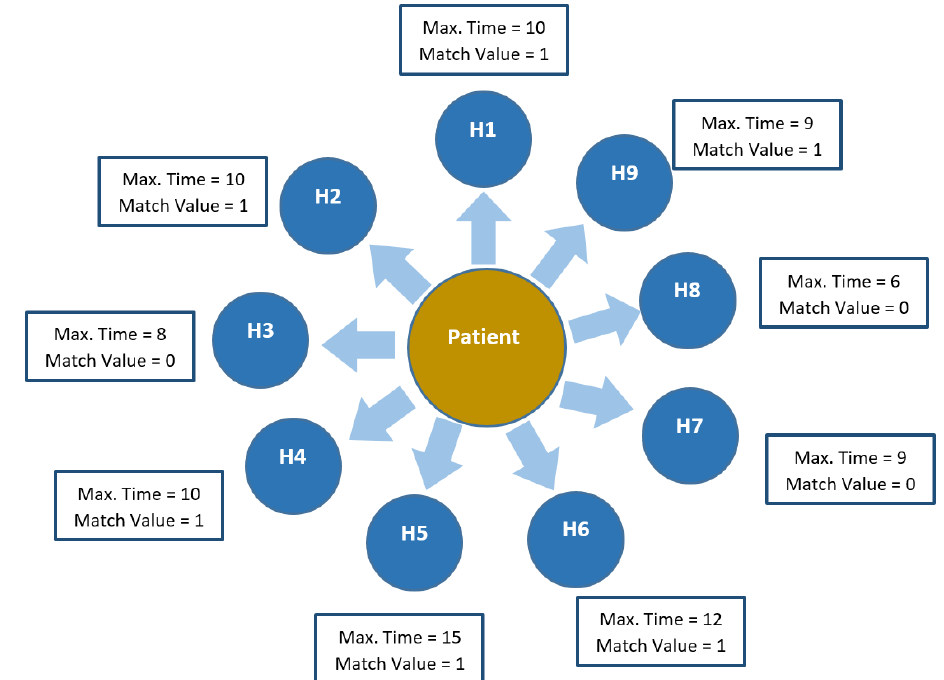
Figure 2. A graphical representation of the objective values of the hospitals after computing them relative to the patient’s